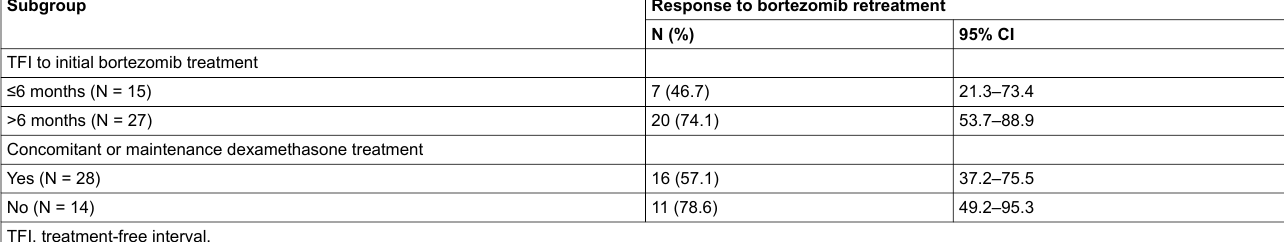
Table 6: Adverse drug reactions a occurring in ≥5% of patients (safety population, N = 43). Primary system organ class (PSOC) Events, n Patients, n (%) Any adverse drug reaction Blood and lymphatic system disorders General disorders and administration site